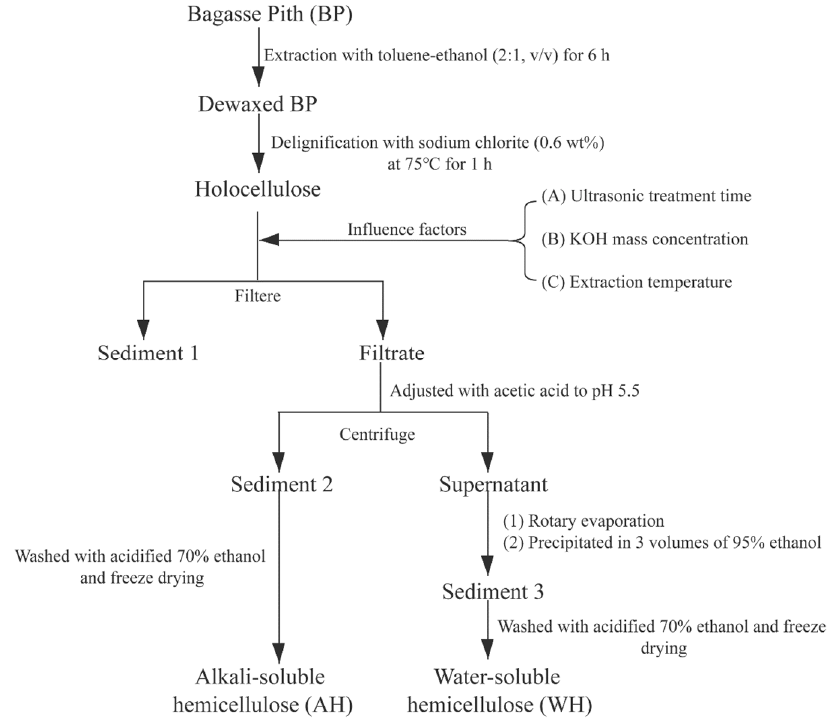
Figure 1. Scheme for extraction of hemicelluloses from BP.